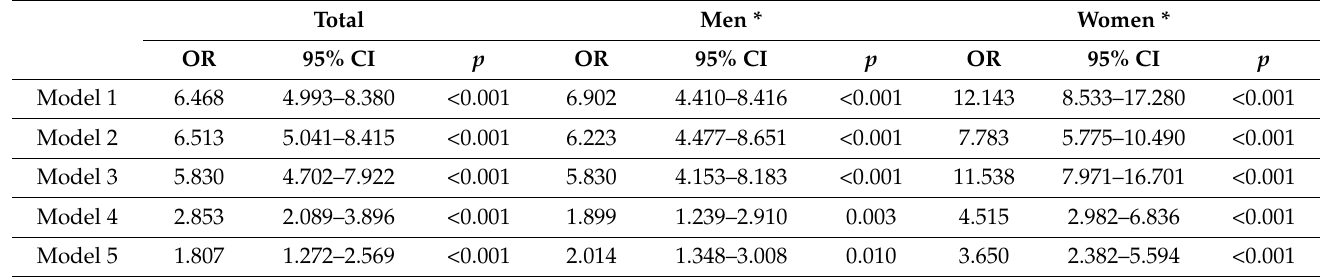
Table 5. Association between neck circumference (categorical data) and the risk of MetS by